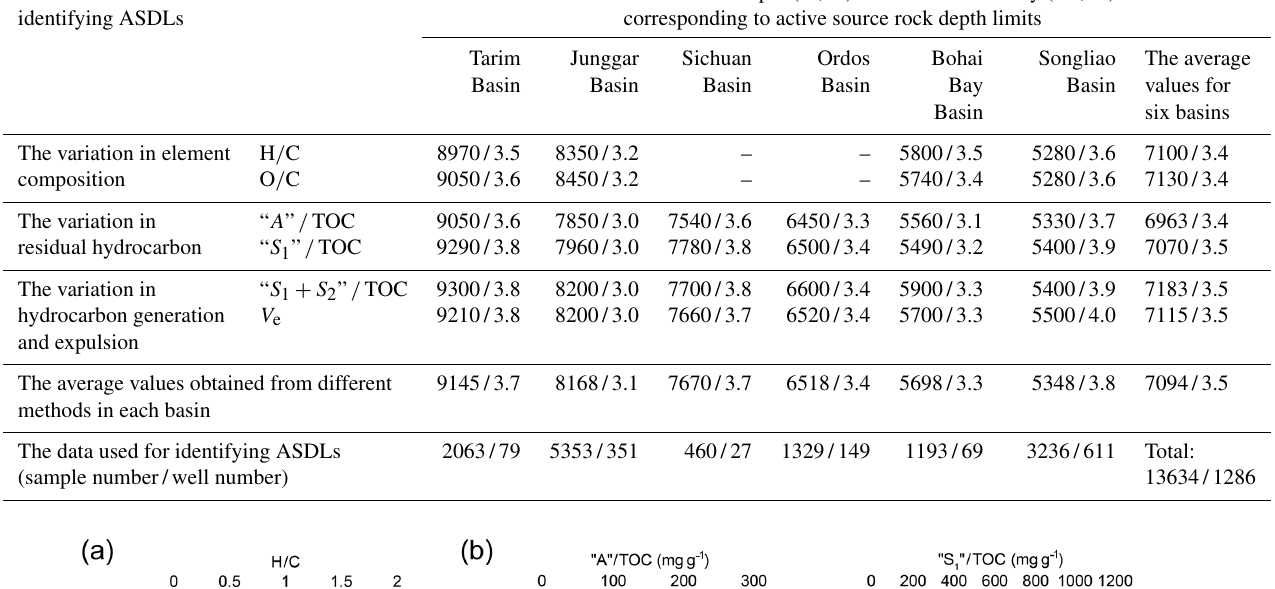
Table 2. Comparison of active source rock depth limits in the six petroliferous basins of China. Research methods and related indicators for